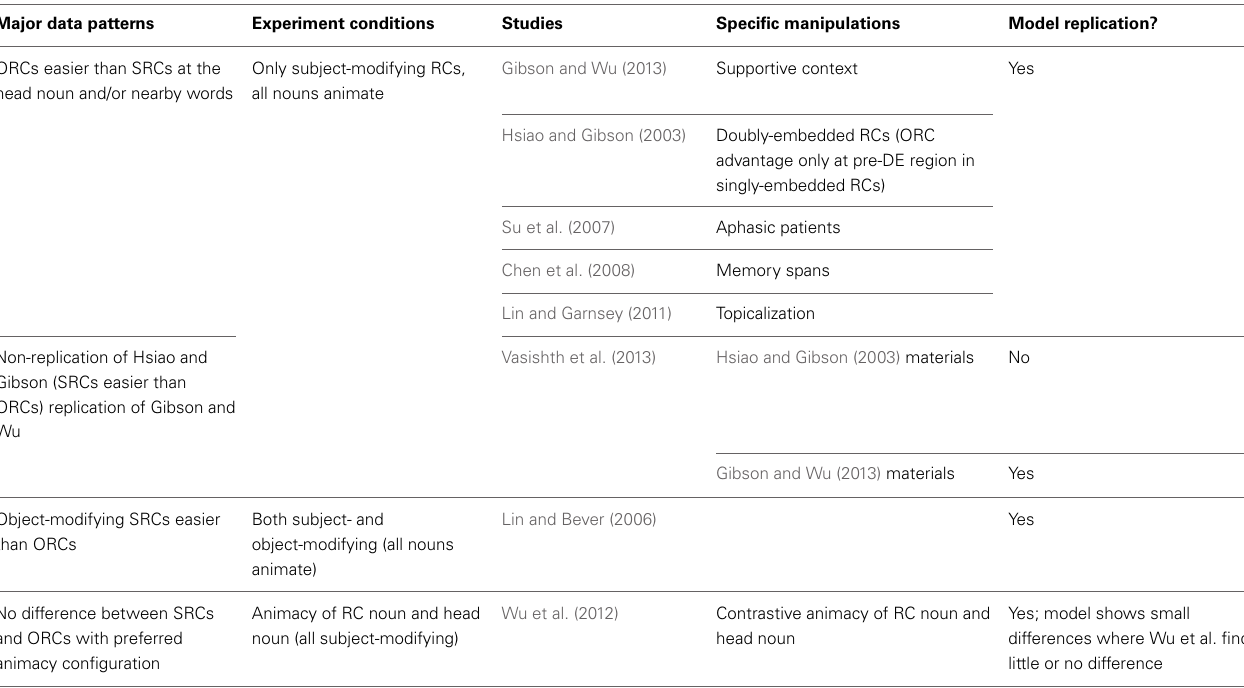
Table 5 | Comparison of experimental materials and major findings of representative human reading time